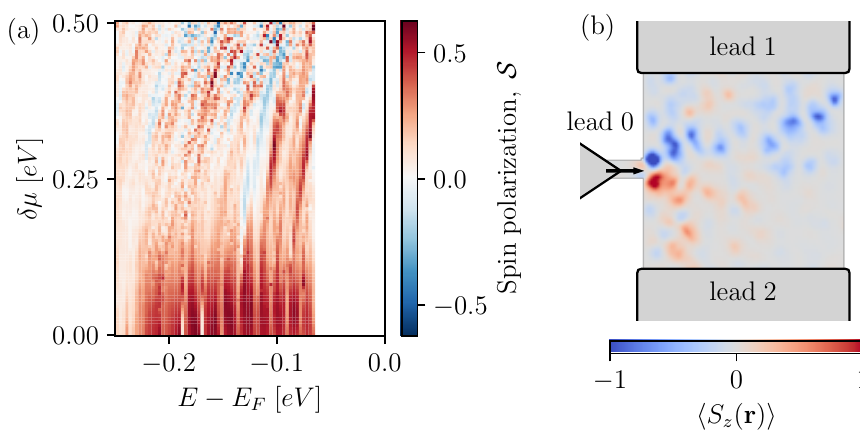
Figure 4: (a) Effects of disorder on the spin transmission in the tight-binding model of monolayer MoS . The polarization is rapidly suppressed for δµ ≈ 0.1eV. (b) 2 〉 showing the breakdown of the spin jets for δµ = 0.1eV and Spatial map of 〈 S z = − E − E F